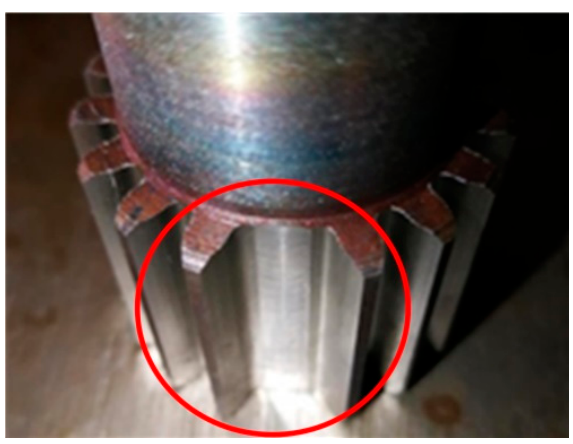
Figure 12. The structure of experimental rig.